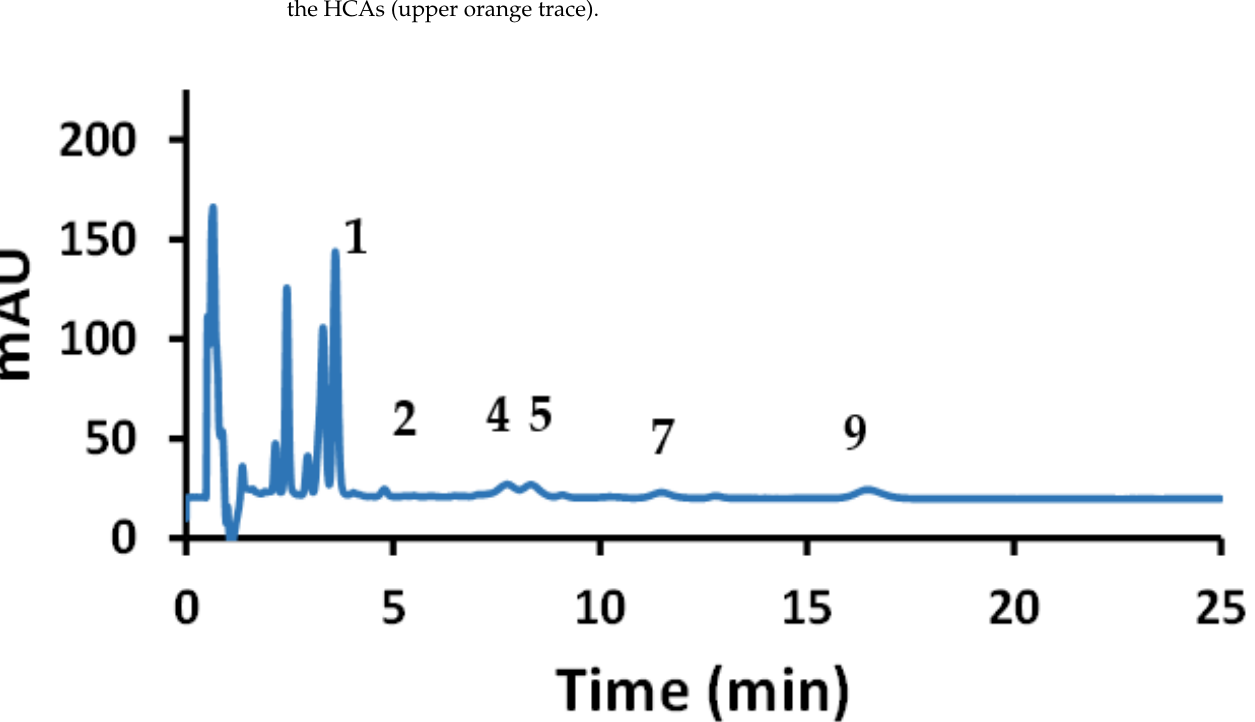
Figure 9. Chromatogram of green coffee diet pill.